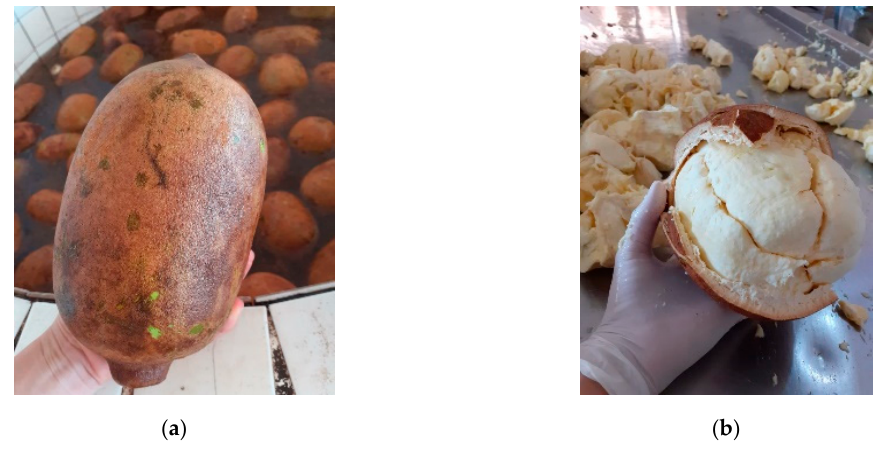
Figure 1. Picture of Cupuaçu ( Theobroma grandiflorum ) ( a ) pods and ( b ) fresh pulp. Courtesy of authors S.K. (Project RECA) and J.M.L.S. (Embrapa), Rio Branco, Acre, Brazil.